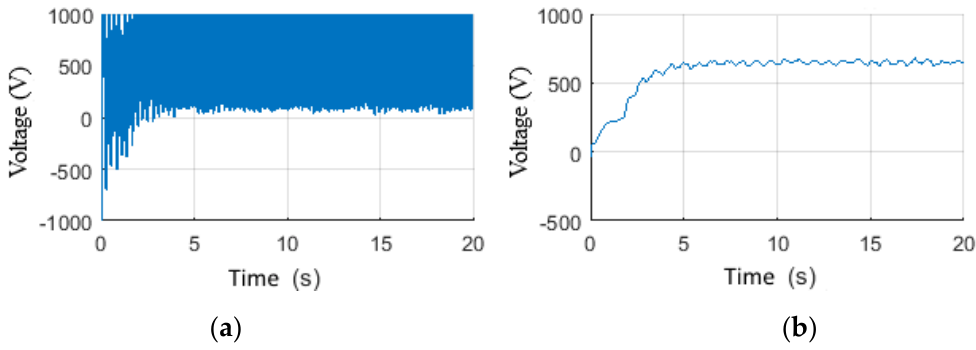
Figure 39. Top drive voltage for Scenario-11 with: ( a ) LQG controller, ( b ) H ∞ controller.